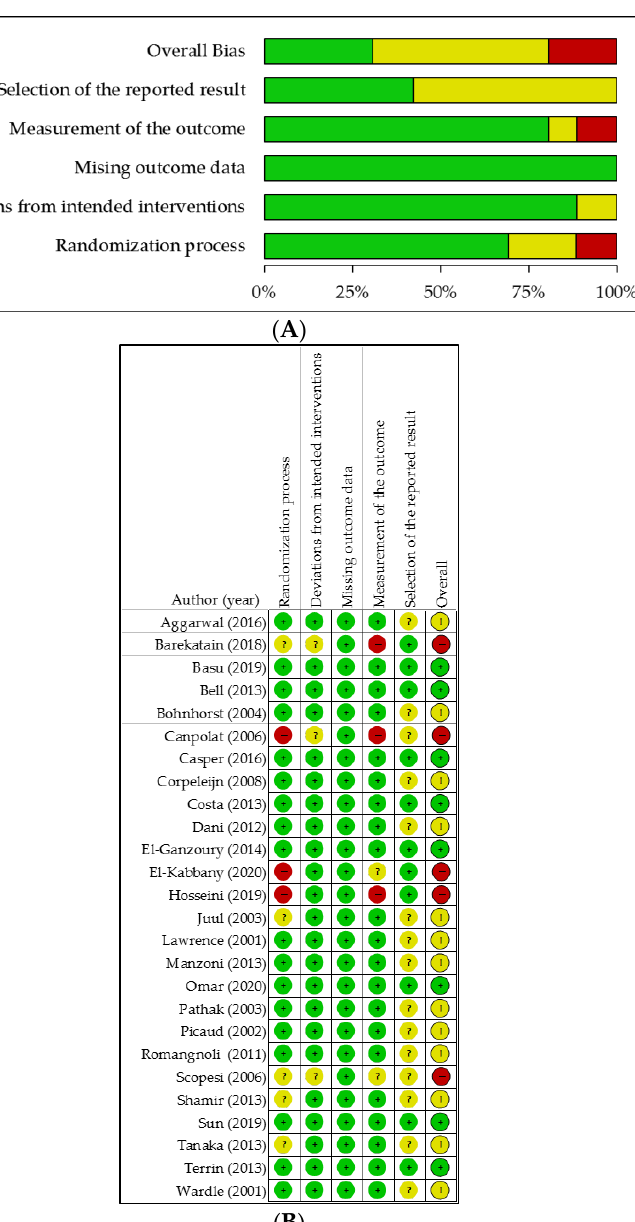
Figure 2. Review author’s risk of bias judgement, presented as percentage across all included studies at each level of risk of bias ( A ) and for each included study ( B ). Green: low risk, yellow: some concerns, red: high risk.